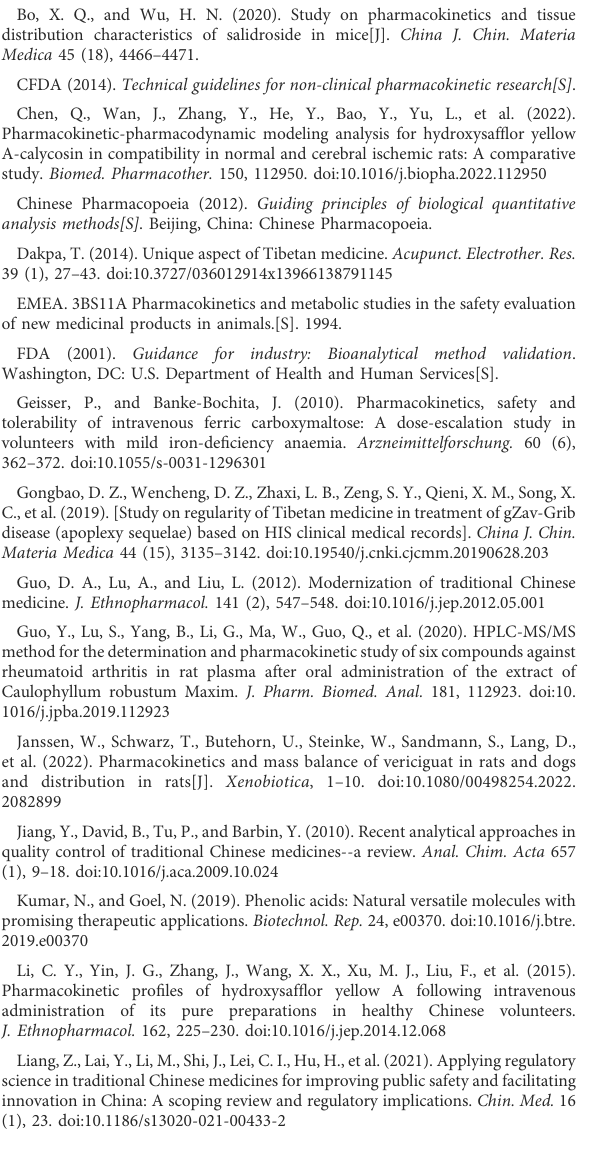
SUPPLEMENTARY FIGURE S2 Ion full scanning mass spectrum of products of agarotetrol, isoliquiritigenin, piperine, ferulic acid, and internal standard. (A) Agarotetrol; (B) isoliquiritigenin; (C) piperine; (D) ferulic acid; (E) interior label. SUPPLEMENTARY FIGURE S3 TypicalMRMchromatogramofagarotetrolandinternalstandardinratplasma by the LC-MS/MS method. I represents the analyte and II represents the internal standard. (A) Blank plasma in rats (double blank); (B) blank plasma with the internal standard (blank); (C) real sample (single administration for 15.0 min); (D) quantitative lower limit sample. SUPPLEMENTARY FIGURE S4 Typical MRM chromatogram of isoliquiritigenin and internal standard in rat plasma by the LC-MS/MS method. I represents the analyte and II represents the internal standard. (A) Blank plasma in rats (double blank);